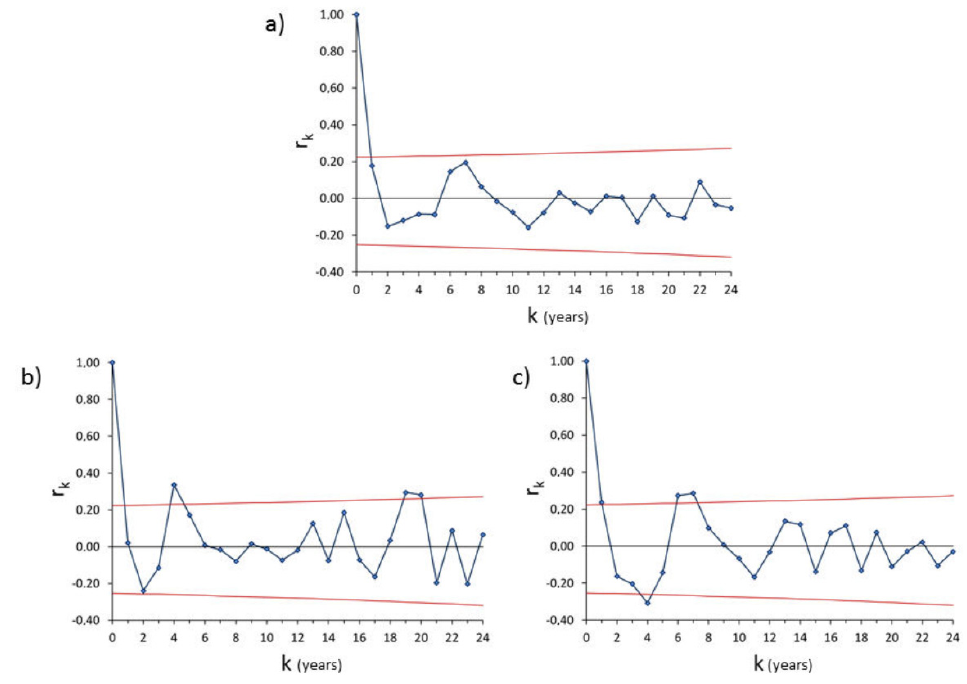
Figure 7. ( a ) Autocorrelogram of the complete 108-year series. ( b ) Autocorrelogram of the first half of the study period (1910/11–1959/60). ( c ) Autocorrelogram of the second half of the study period (1960/61–2017/18). The Anderson limits, which define the time-independent region, are indicated for each case.